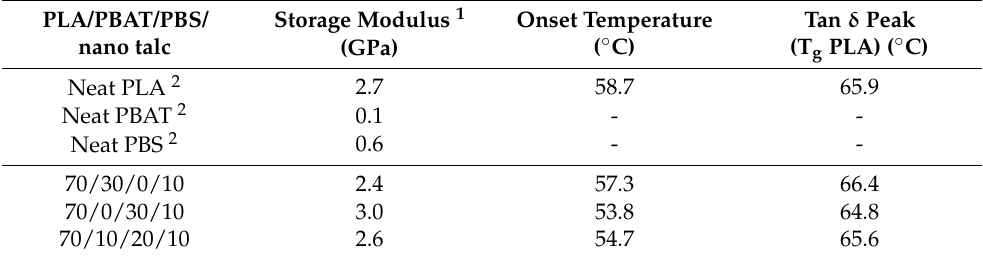
Figure 3. Dynamic mechanical properties of PLA/PBAT/PBS/nano talc composite 3D prints: ( a ) Storage modulus; ( b ) Tan δ . Table 4. Dynamic mechanical properties of neat polymers and PLA/PBAT/PBS/nano talc composite 3D